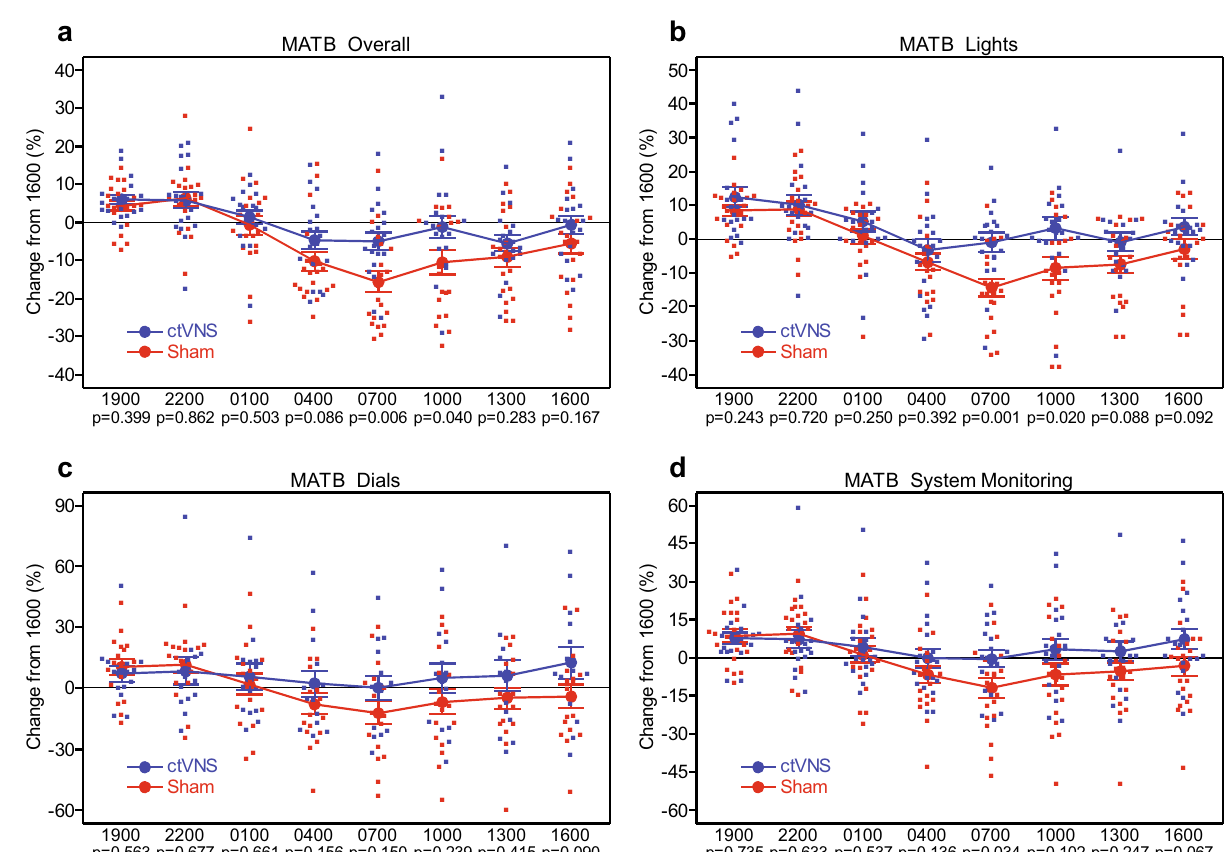
Fig. 1 AF – MATB task overall, lights, dials, and system monitoring throughput capacity as a change from 1600. a Throughput capacity on all subtasks of the AF – MATB as a change from 1600. b Throughput capacity on the lights subtask of the AF – MATB as a change from 1600. c Throughput capacity on the dials subtask of the AF – MATB as a change from 1600. d Throughput capacity on the system monitoring subtask of the AF – MATB as a change from 1600. Error bars on a – d are mean + / −